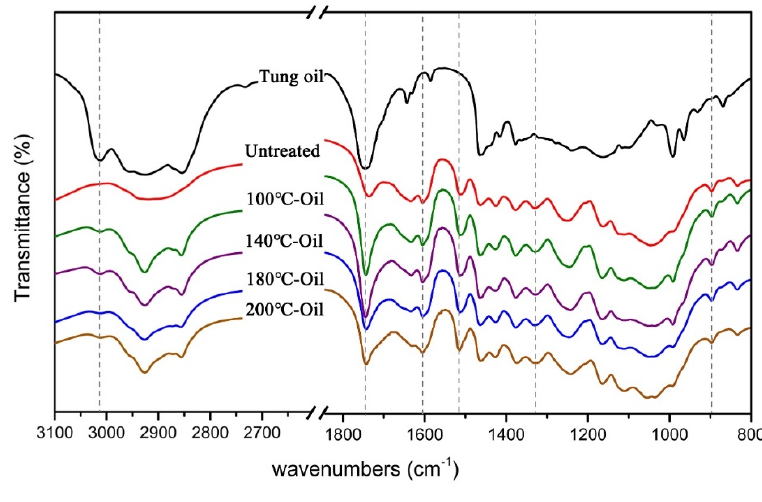
Figure 4. FTIR spectra of moso bamboo.